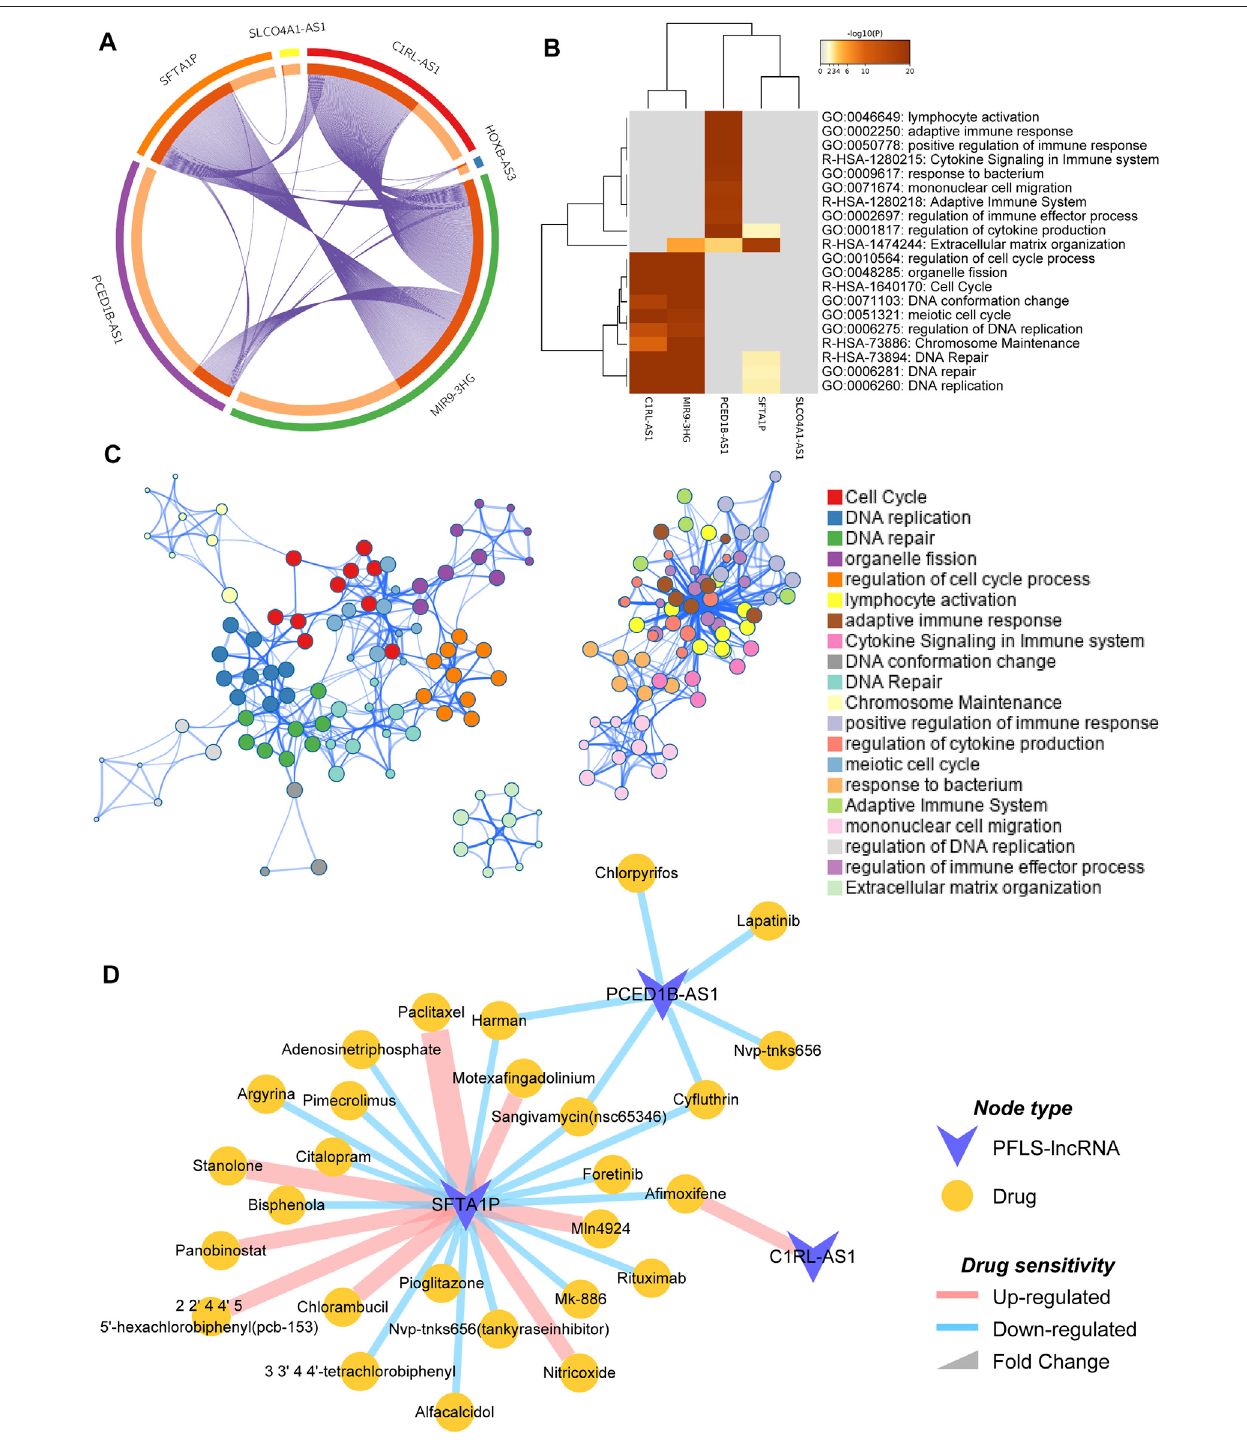
FIGURE 6 | Functional enrichment analysis and potential clinical utilities of PFLS. (A) Circosplot showing the overlap among PFLS co-expressed genes. Purple curveslinkidenticalgenes.Theinnercirclerepresentsgenelists,wherehitsarearrangedalongthearc.Genesthathitmultiplelistsarecoloredindarkorange,andgenes unique to a list are shown in light orange. (B) Network of enriched terms colored by functional clusters, where nodes that share the same functional cluster are typically close to each other. (C) Heatmap of enriched terms across PFLS co-expressed genes, colored by p -values. (D) PFLS-related drug sensitivity network.